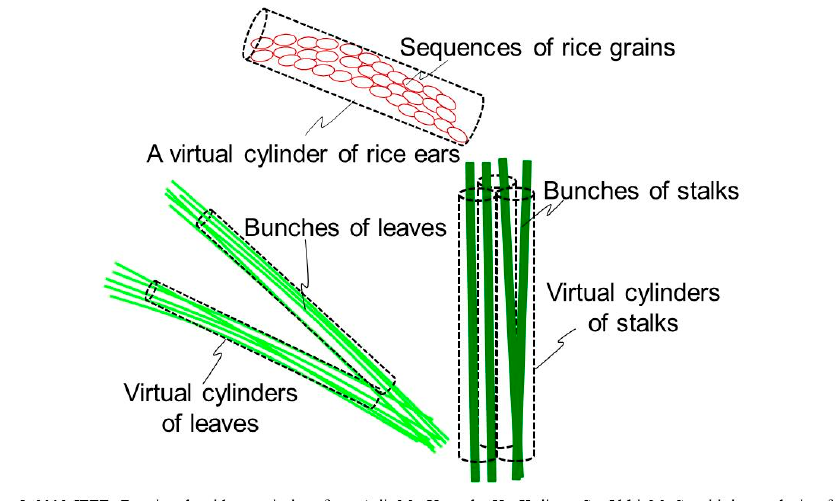
Figure 12. Cylinder models of sequences of rice ears, bunches of leaves and bunches of stalks [36].